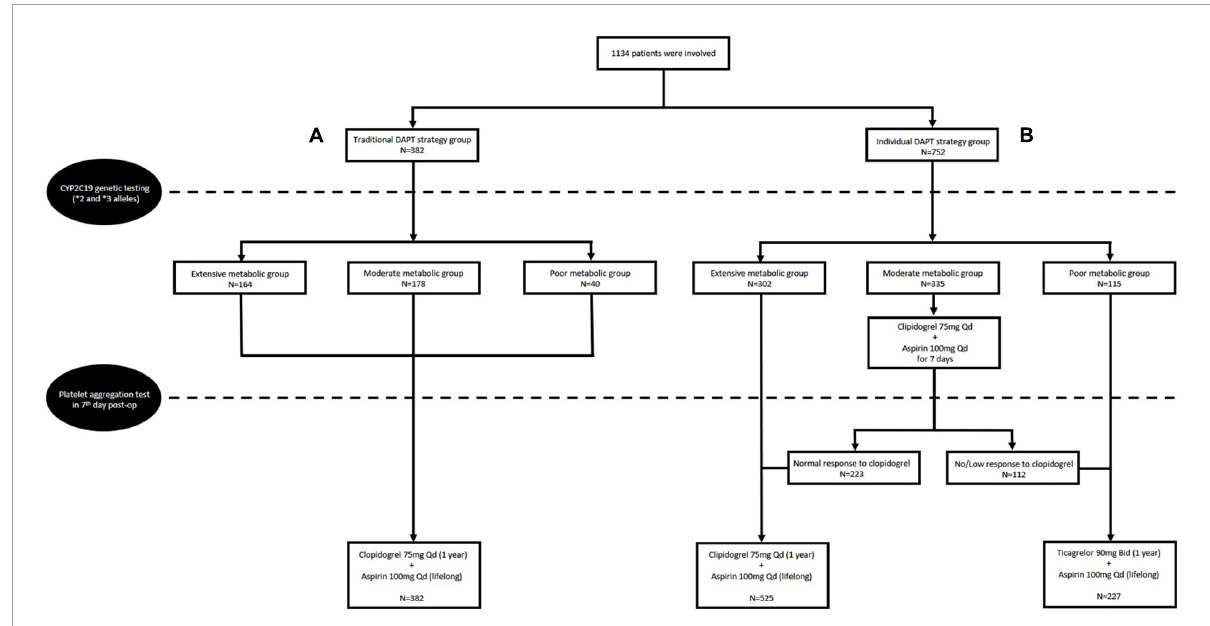
FIGURE1 Flow chart of the study design and the traditional dual antiplatelet therapy (DAPT) group (A) and individual DAPT group (B)